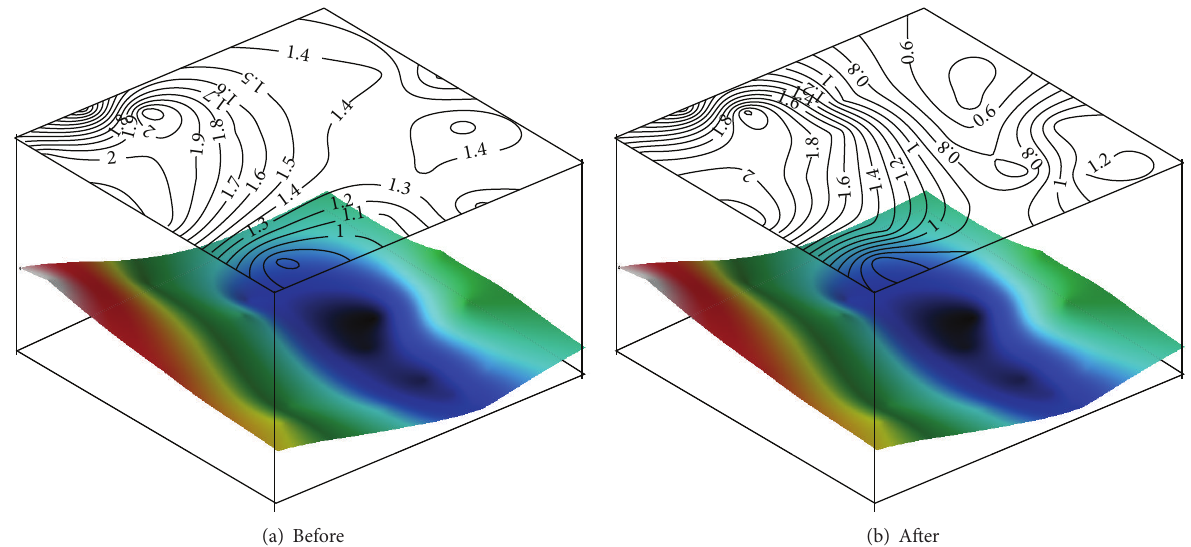
Figure 8: Overall wind velocity distribution chart within location before and after construction of embankment (wind angle = SSW).